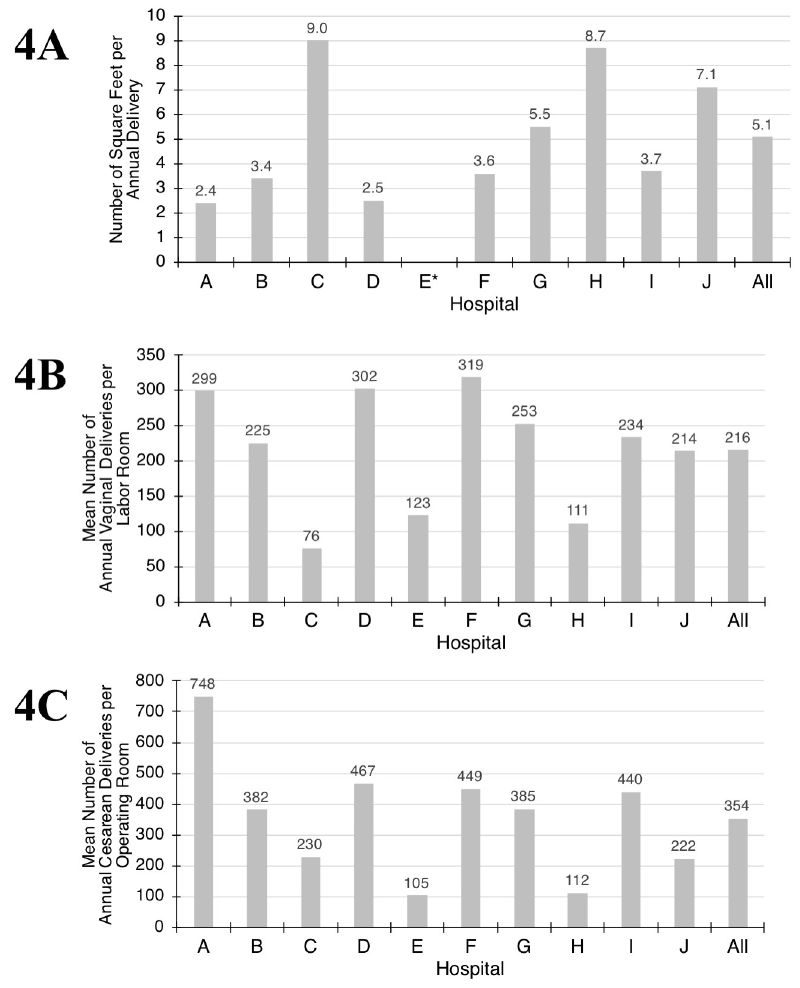
Fig 4. Unit, labor room and operating room delivery capacity. 4A. Ratio of labor unit square footage to annual delivery volume, or the number of square feet per annual delivery by hospital. � Hospital E excluded (unable to measure unit square footage). 4B. Ratio of annual vaginal deliveries to labor room count, or the mean number of vaginal deliveries in each labor room per year by hospital. 4C. Ratio of annual cesarean deliveries to operating room count, or the mean number of Cesarean deliveries in each operating room per year by